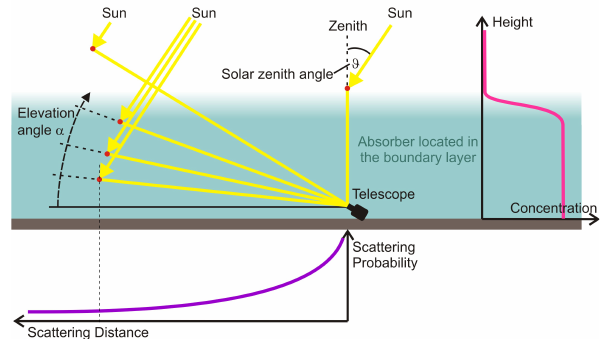
Fig. 1. Sketch of the light paths in a single-scattering case when this approach can be applied (lowest three elevation angles). Pho- tons coming from the sun are scattered in the atmosphere (red dots) before they reach the MAX-DOAS device. An elevated aerosol load in the lowest atmosphere shortens the light path and can lead to in- distinguishable dSCD values for low elevation angles. On the right- hand side, the concentration profile of the absorber and, in the lower part, the photon scattering probability versus the distance from the telescope are indicated. For further information see